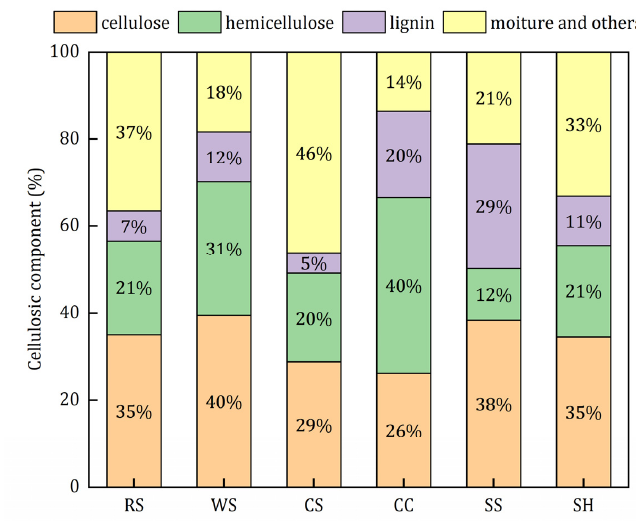
Figure 1. Cellulosic components of the investigated agricultural